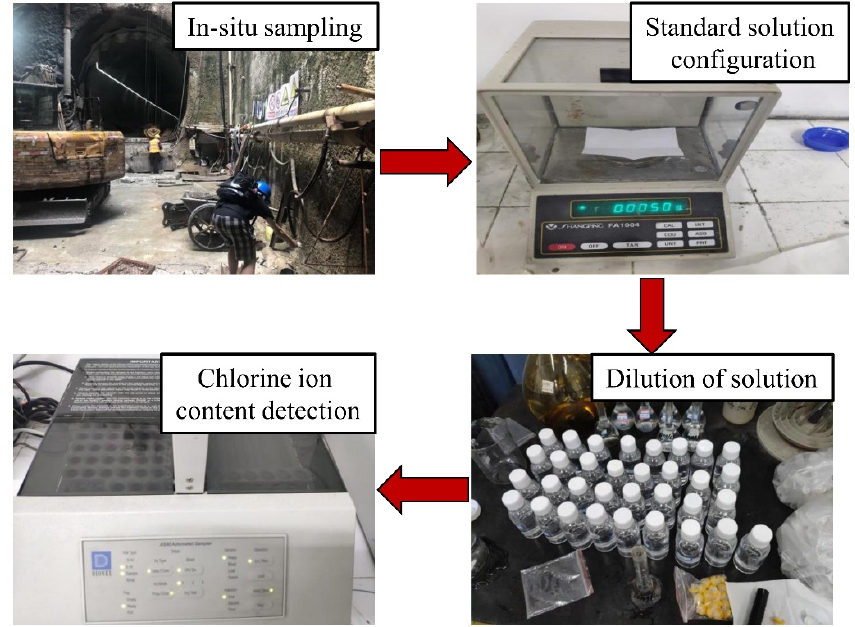
Figure 1. Determination of chloride ion content in subway service environments.